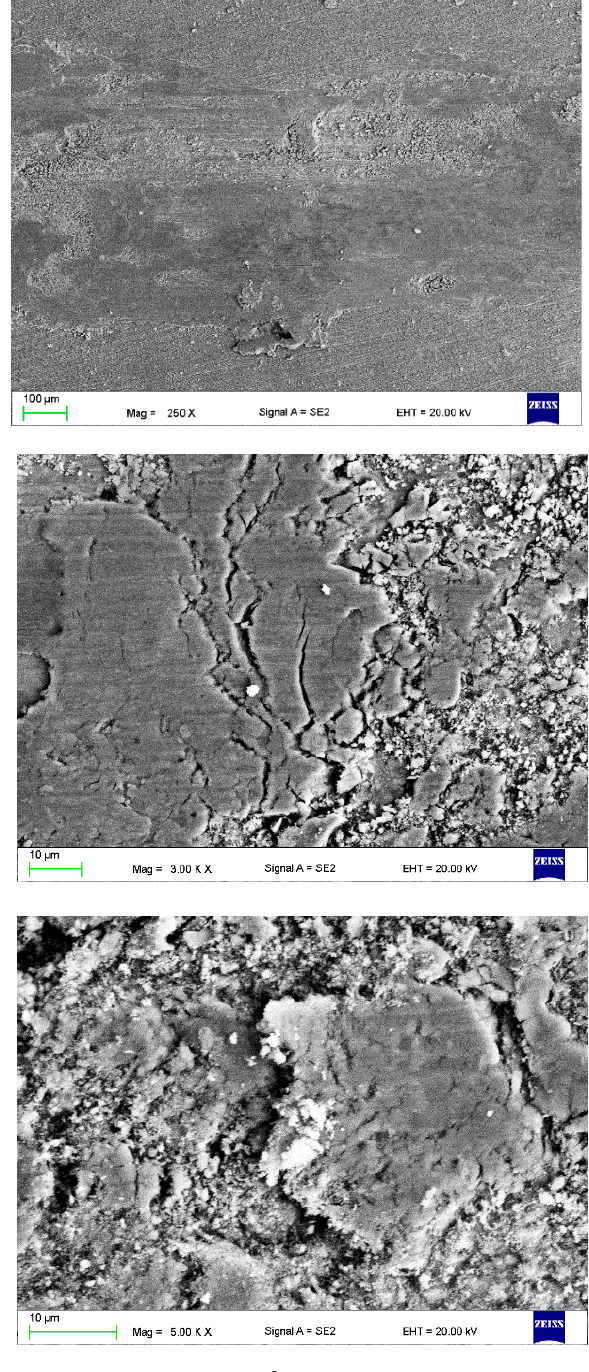
Figure 16. Wear track ( a , b ) of the tested CrAl v = 0.8 mm 3 /min layer and ( c ) wear debris.